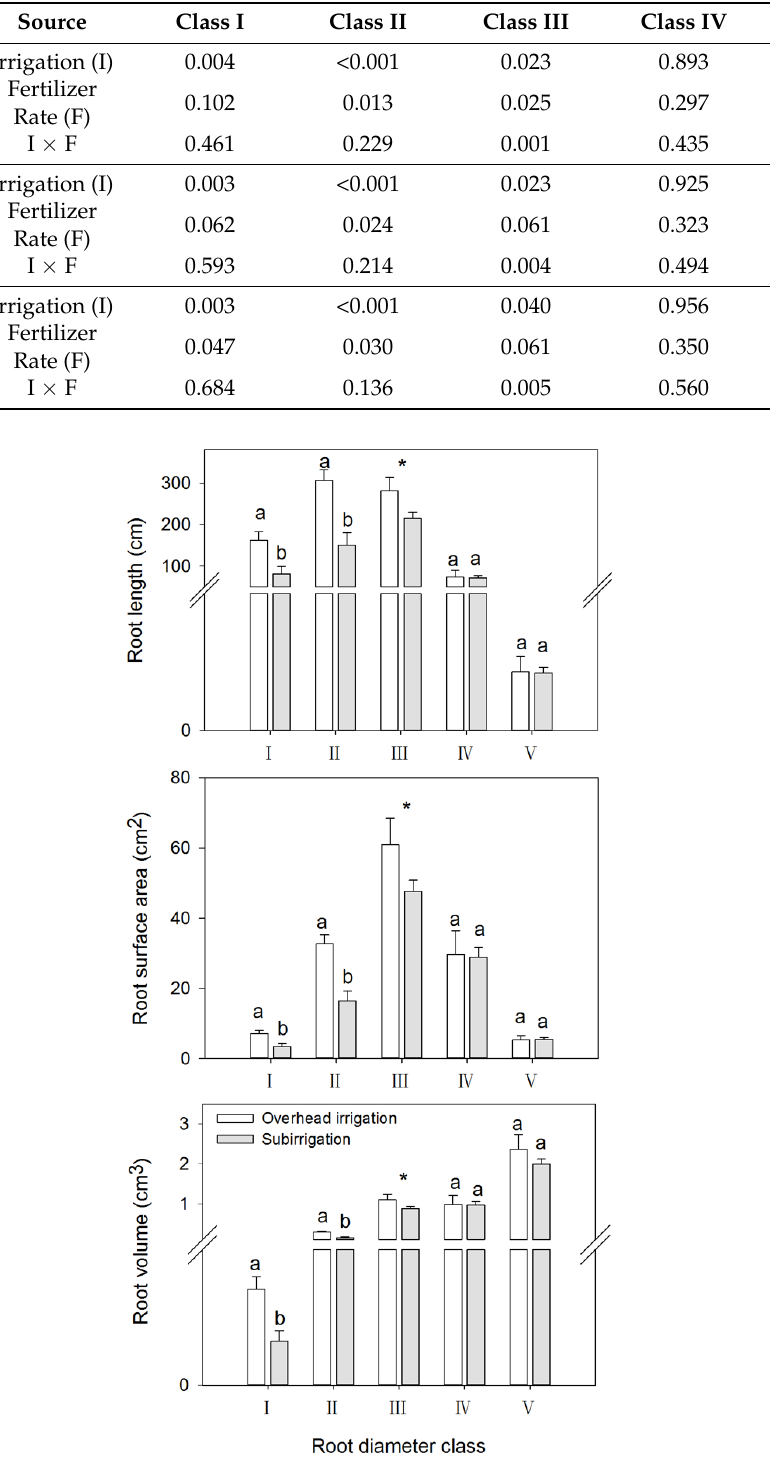
Figure 4. Larch seedling root length, root surface area, and root volume among root diameter classes at final harvest (203 days after sowing; 10 November). Treatments marked with different lower-case letters differ statistically at each root diameter class according to Tukey’s honestly significant difference α = 0.05. An asterisk means a significant interaction for class III roots and see Figure S3.